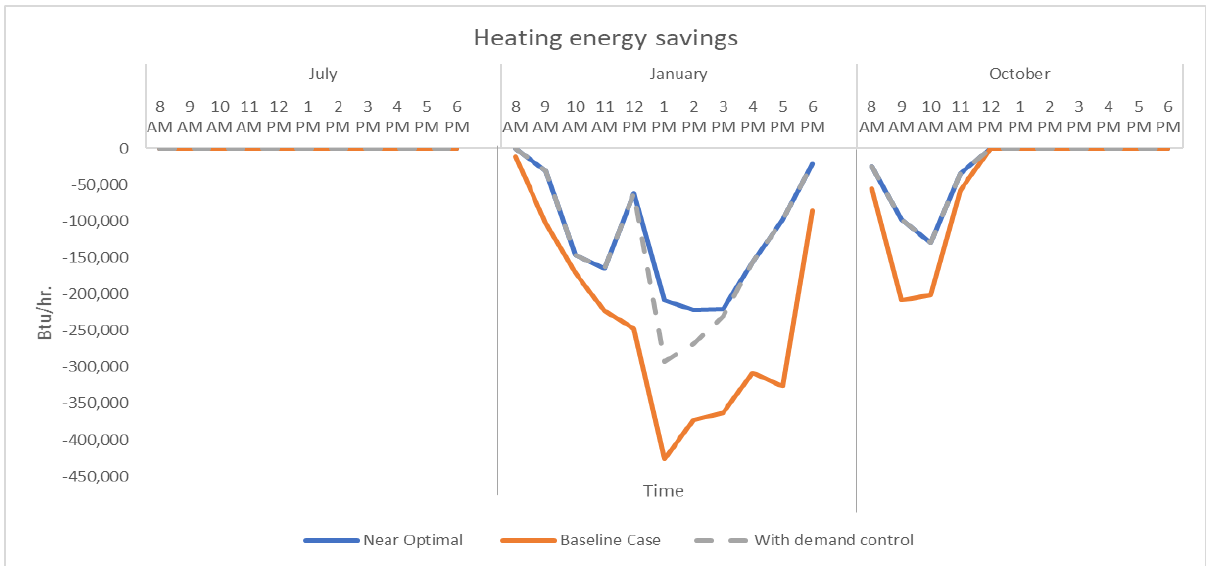
Figure 15. The heating energy savings for each day being